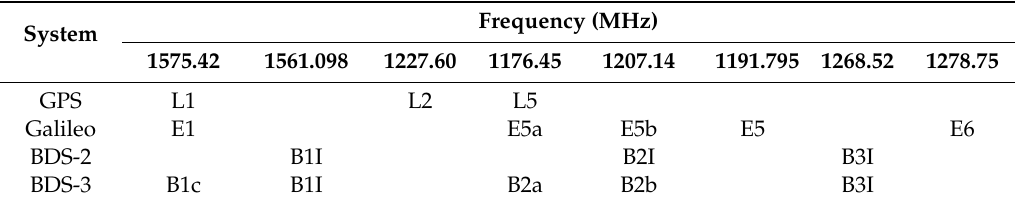
Table 1. Open signals of GPS, Galileo, and BeiDou navigation satellite system